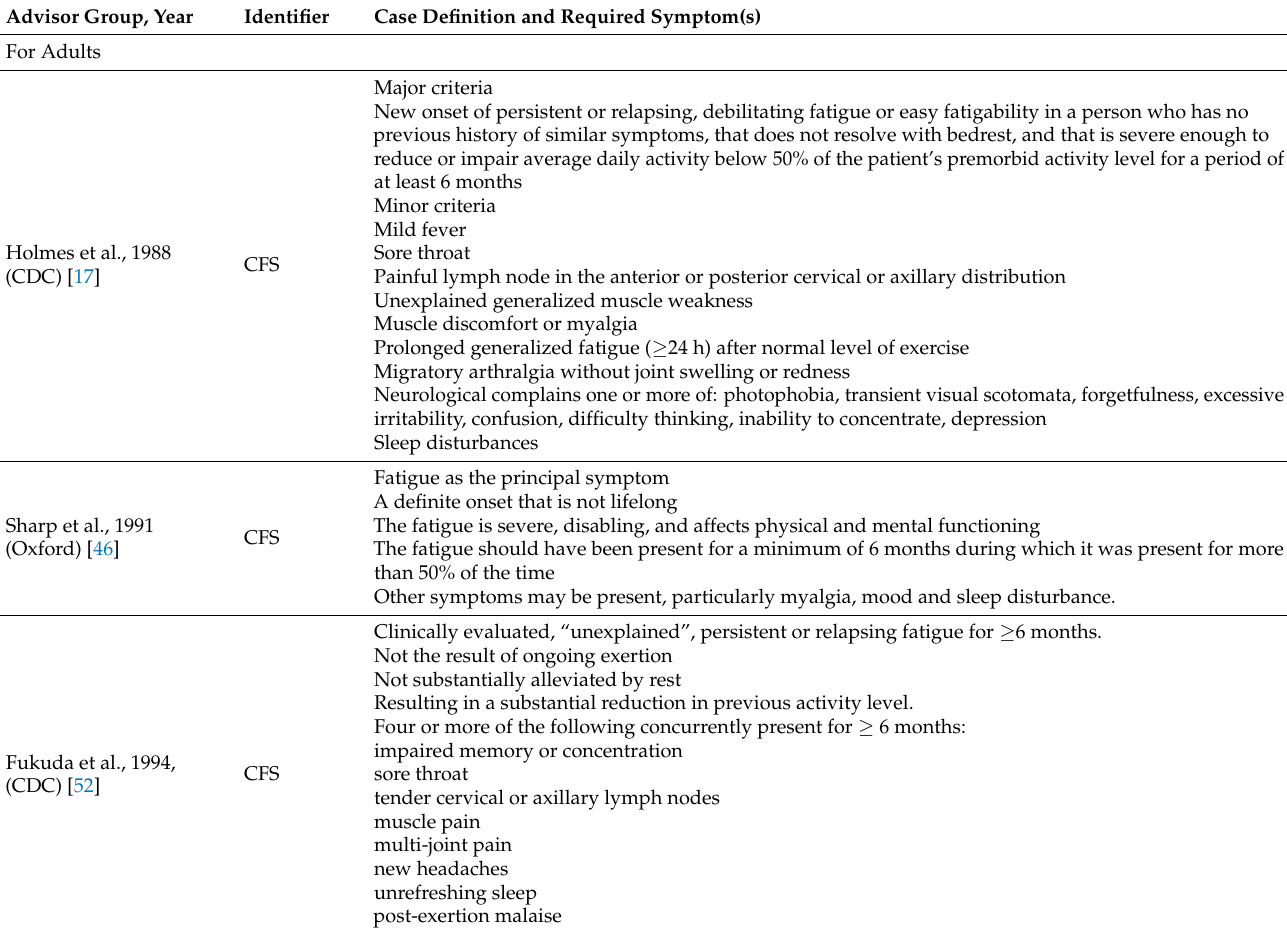
Table A1. Case definitions for the diagnosis of ME/CFS over